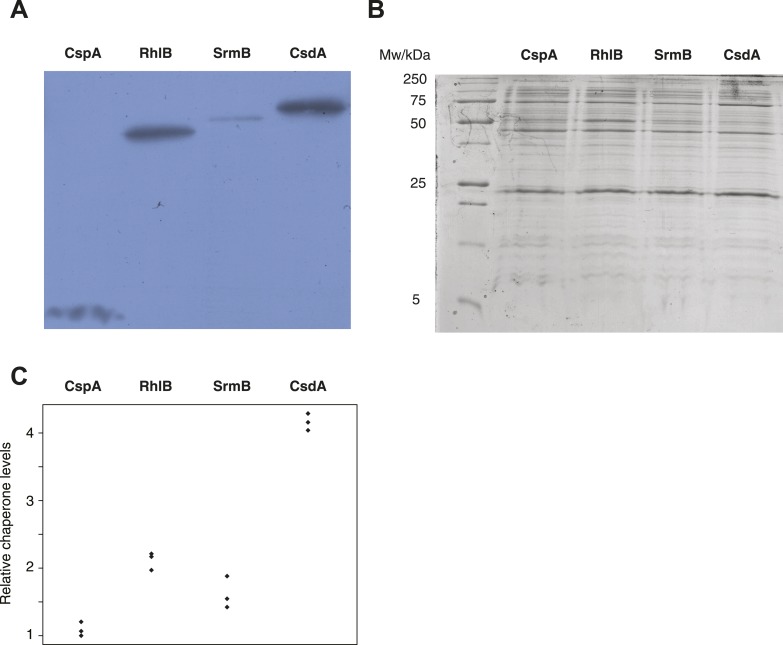
Relative chaperone abundances.(A) Representative Western blot for evolved ΔmutH strains overexpressing one of the focal RNA chaperones. Molecular weights (from nucleotide sequence): CspA, 7.403 kD; RhlB, 47.126 kD; SrmB, 49.914 kD; CsdA, 70.546 kD. (B) Representative Coomassie-stained SDS-PAGE gel. (C) Relative chaperone levels are defined as the ratio of Western blot intensity to Coomassie intensity (see ‘Materials and methods’). The lowest ratio detected across triplicate experiments in all strains was set to one. Comparing these ratios between strains overexpressing different RNA chaperones gives a semi-quantitative indication of relative chaperone abundances. For example, CsdA levels in CsdA-overexpressing cells are ∼fourfold higher than CspA levels in CspA-overexpressing cells. Note that this metric does not allow conclusions about the absolute fraction of total protein that is occupied by each chaperone in the different strains.